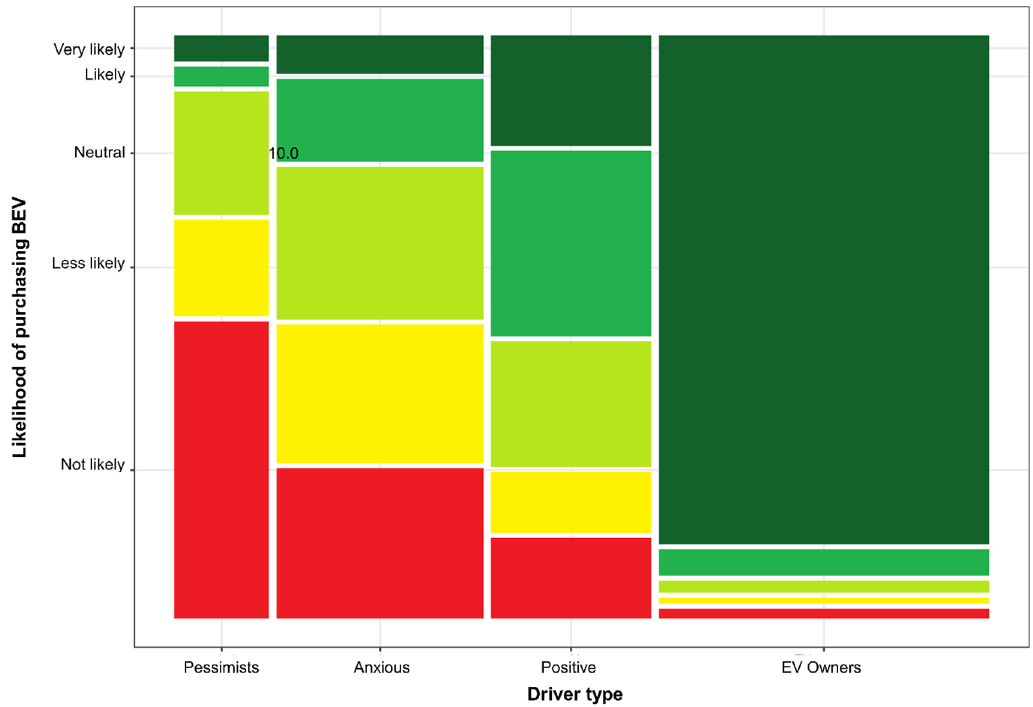
Figure 2. Likelihood of purchasing a fully electric vehicle (BEV) (A15-1) as a ratio of Driver Type (A16). Motorists were segmented into four Driver Types, dependent on their attitude to EVs, and as attitude to EVs improved, the likelihood of purchasing a BEV increased. Most EV Owners indicated they were ‘very likely’ to buy a BEV the next time they buy a car.